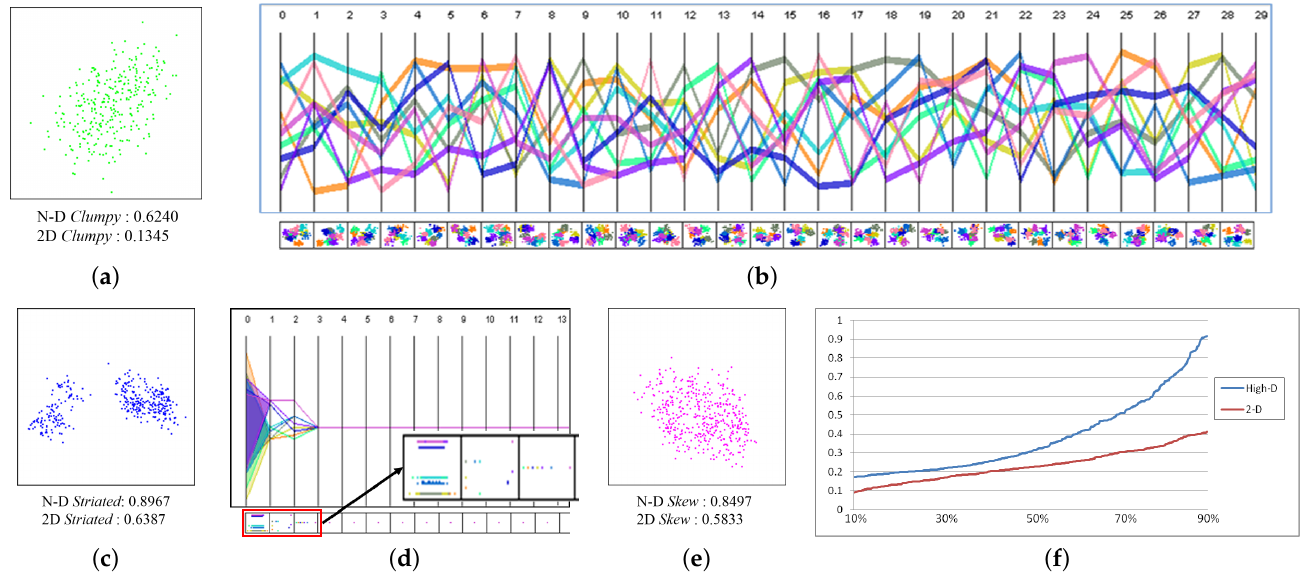
Figure 5. Three clusters of the Gaussian dataset. ( a ) MDS-LDA of the green cluster with N-D and 2-D clumpy values. The green cluster is composed of 10 sub-clusters. ( b ) The green cluster in parallel coordinates display (PCD). The 10 sub-cluster centers shown in different colors. The clusters themselves are well distinguishable in the bivariate scatterplots below. ( c ) MDS-LDA of the blue cluster with N-D and 2-D striated values. It has 9 sub-clusters which run along parallel lines. ( d ) Partial PCD of ranges of the sub-clusters shown in different colors and the first 3 zoomed scatterplots of adjacent dimensions. ( e ) MDS-LDA of the magenta cluster with N-D and 2-D skew values. ( f ) Distribution of edge lengths in the 2-D MST and N-D MST. The vertical axis indicates